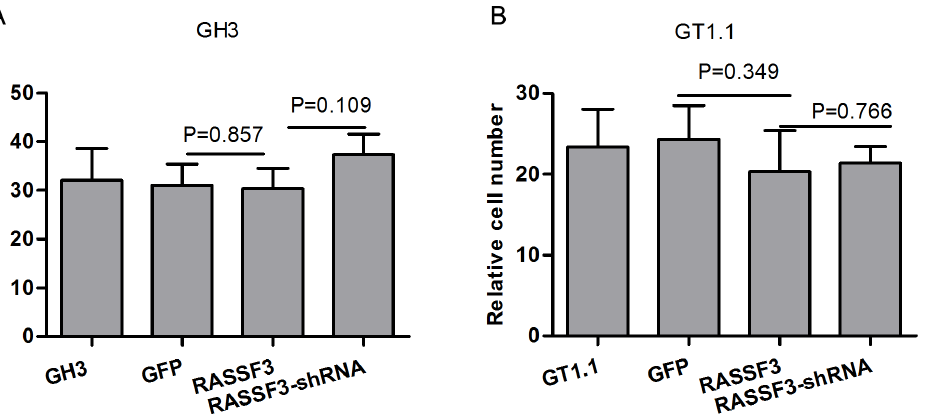
Figure 7. Effect of RASSF3 expression on cell invasive capacity in the Matrigel model. Matrigel assays showing the effect of Lenti-RASSF3 shRNA and Lenti-RASSF3 on the invasive potential of GH3 and GT1.1 cells. The bar graph indicates the mean number of invaded cells at 24 h after top-side cell seeding. Lenti-RASSF3 or Lenti-shRNA did not affect invasion of GH3 and GT1.1 cells.